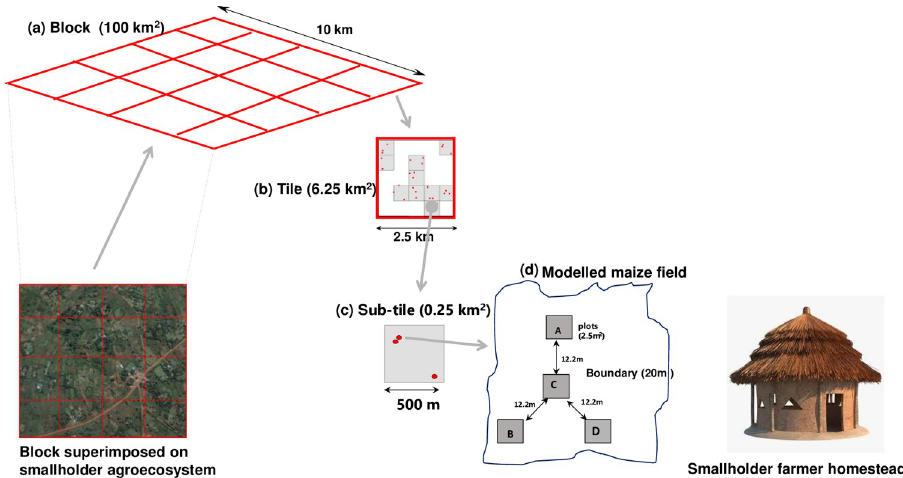
Fig 3. The Land Degradation Sampling Framework (LDSF) used for the sampling strategy (a) Square block measuring 100 km 2 , (b) Tile 6.25 km 2 (c) Sub-tile with randomly selected maize fields (d) maize field (0.25 km 2 ) with e) plots (A, B, C, D) in a Y frame layout, (12.2 m radius distributed uniformly at 360˚). The plots measure 2.5 m 2